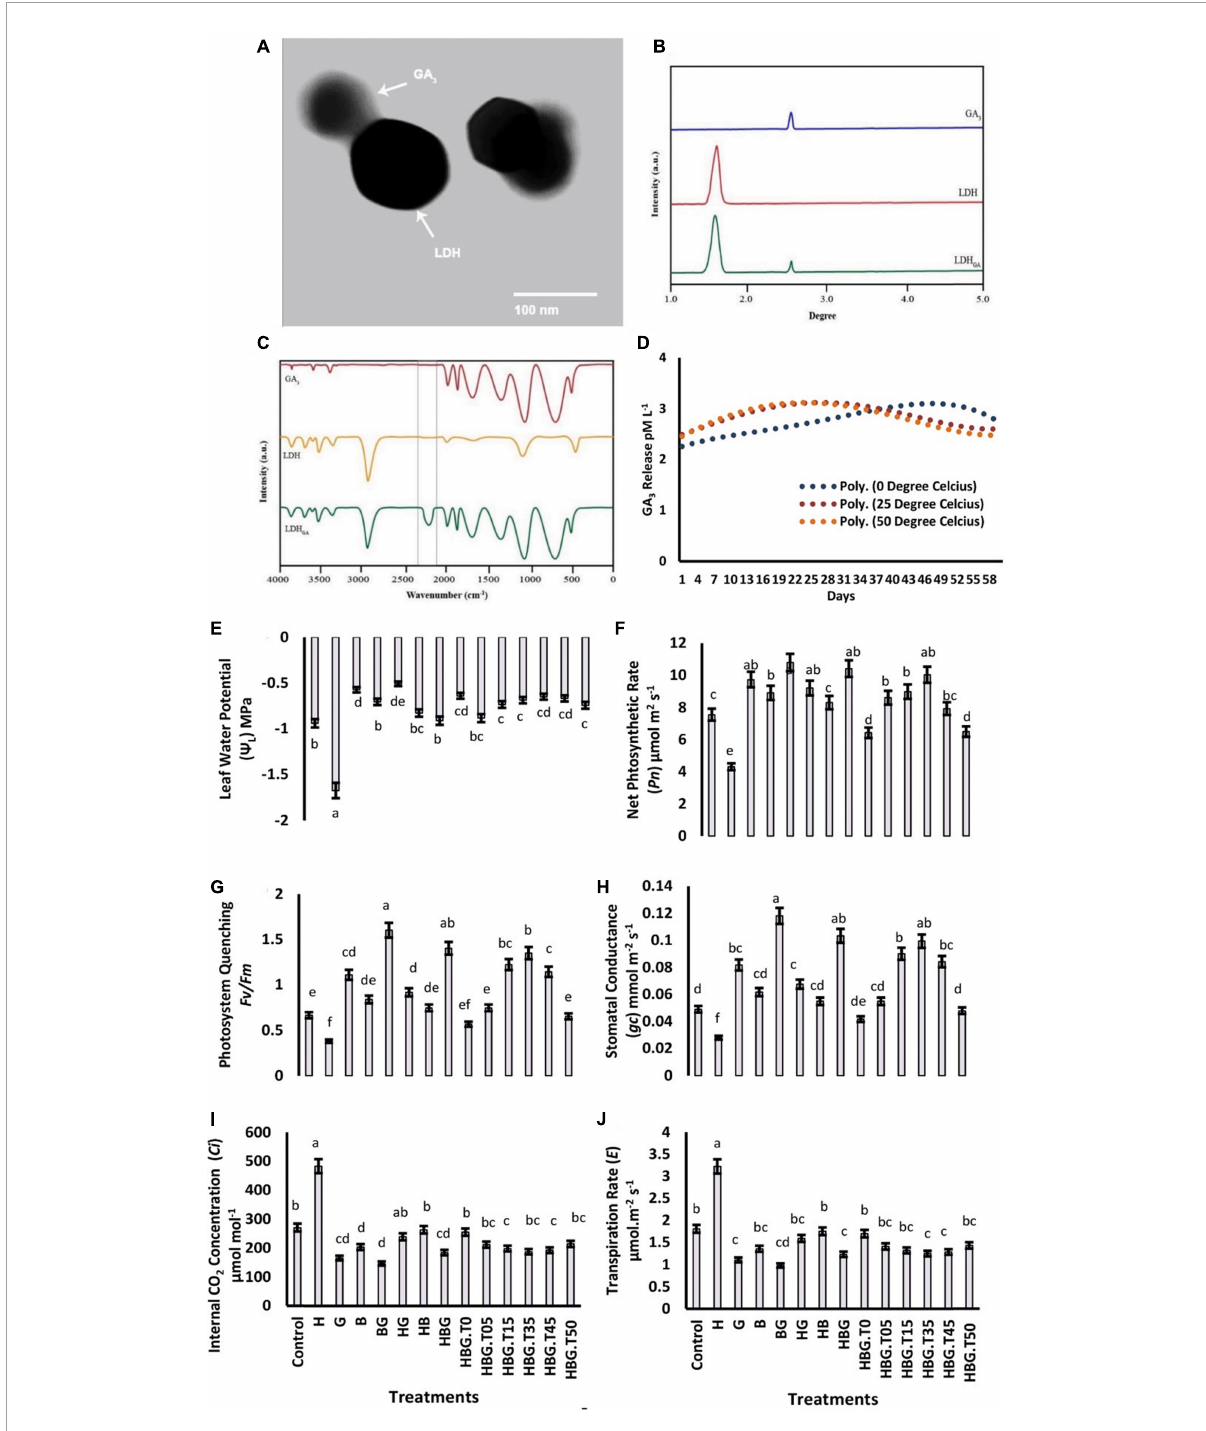
FIGURE1 Electron microscopic image of bioclay nanoparticle with impregnated GA 3 (A) . X-ray diffraction analysis-XRD of gibberellic acid-GA 3 , bioclay-LDH, and gibberellic acid impregnated bioclay-LDH GA (B) . Fourier-transform infrared spectroscopic-FTIR analysis of GA 3 , LDH, and LDH GA (C) . Time course relesse of GA3 molecules by bioclay nanoparticles at three different temperatures, i.e., (0, 25, and 50 degree celcius (D) . Effect of GA 3 on photosynthesis-related parameters of Brassica alboglabra under HCB toxicity, and temperature stress. Leaf relative water content (E) , Net photosynthesis rate (F) , Maximum quality yield of PS-II (G) , Stomatal conductance (H) , Internal CO 2 concentration (I) , Transpiration rate (J) . Values demonstrate means ± SD ( n = 5). Different letters indicate a significant difference among the treatments ( P ≤ 0.05). H = HCB; G = GA 3 , B = Bioclay, T0 = 0 ◦ C, T05 = 05 ◦ C, T15 = 15 ◦ C, T35 = 35 ◦ C, T45 = 45 ◦ C, T50 = 50 ◦ C. All treatments without temperature tags got a continuous incubation temperature of 25 ◦